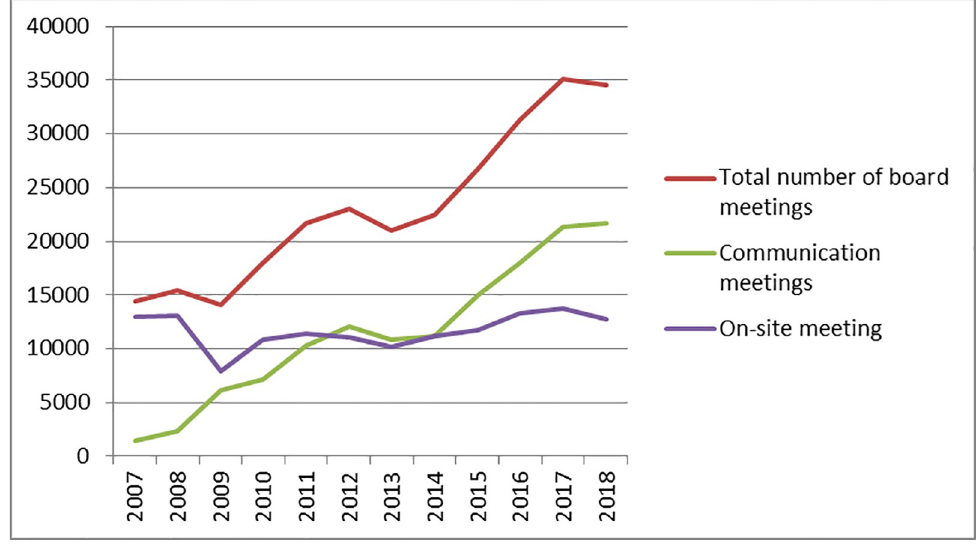
Fig 1. Number of the board meetings.